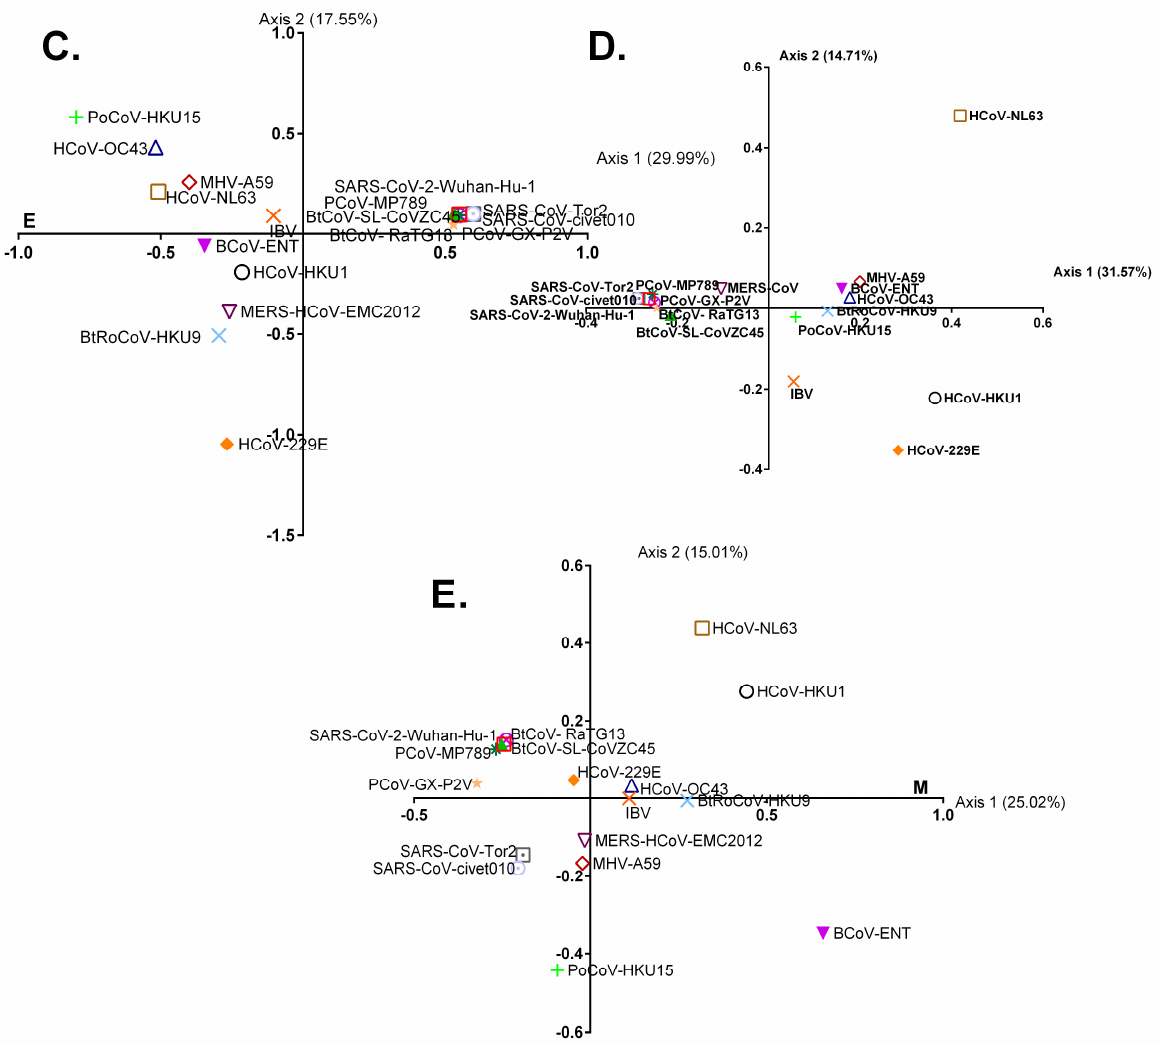
Figure 5. Correspondence analyses based on relative synonymous codon usage in the entire coding genomic sequences ( A ), spike ( B ), envelope ( C ), nucleocapsid ( D ), and membrane ( E ) encoding sequences of CoVs infecting diverse hosts.